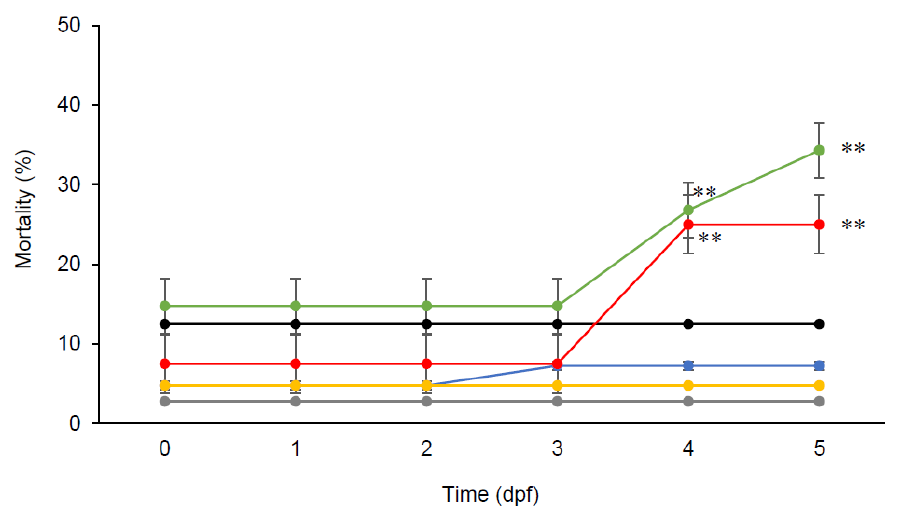
Figure 1. Toxicity of chlorogenic acid (0 µ M ( • ), 50 µ M ( • ), 100 µ M ( • ), 250 µ M ( • ), 500 µ M ( • ), and 700 µ M ( • )) in zebrafish embryos over a 5-day period. Data presented are means ± SD ( n = 4, 10 embryos each replicate). ** p < 0.01. Pharmaceutics 2020 , 12 , x FOR PEER REVIEW